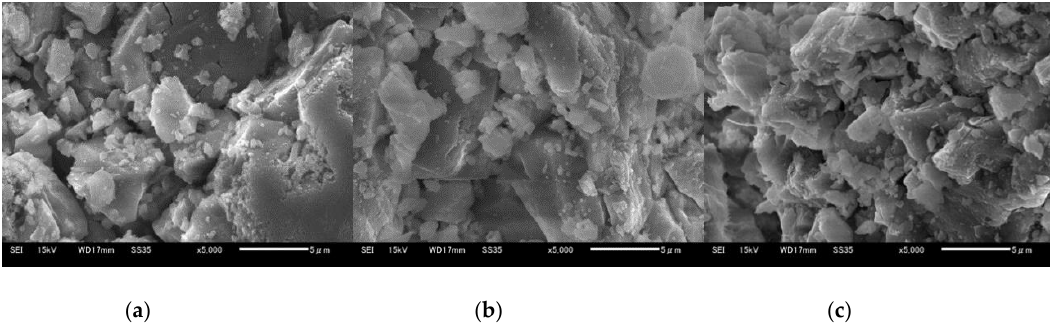
Figure 14. SEM images of 710–1000 µmφ ( a ) Ofunato CaO, ( b ) Ofunato Ca(OH) 2 after 1st hydration reaction, ( c ) Ofunato CaO after 1st dehydration reaction after decarbonization without keeping time in TGA-51.